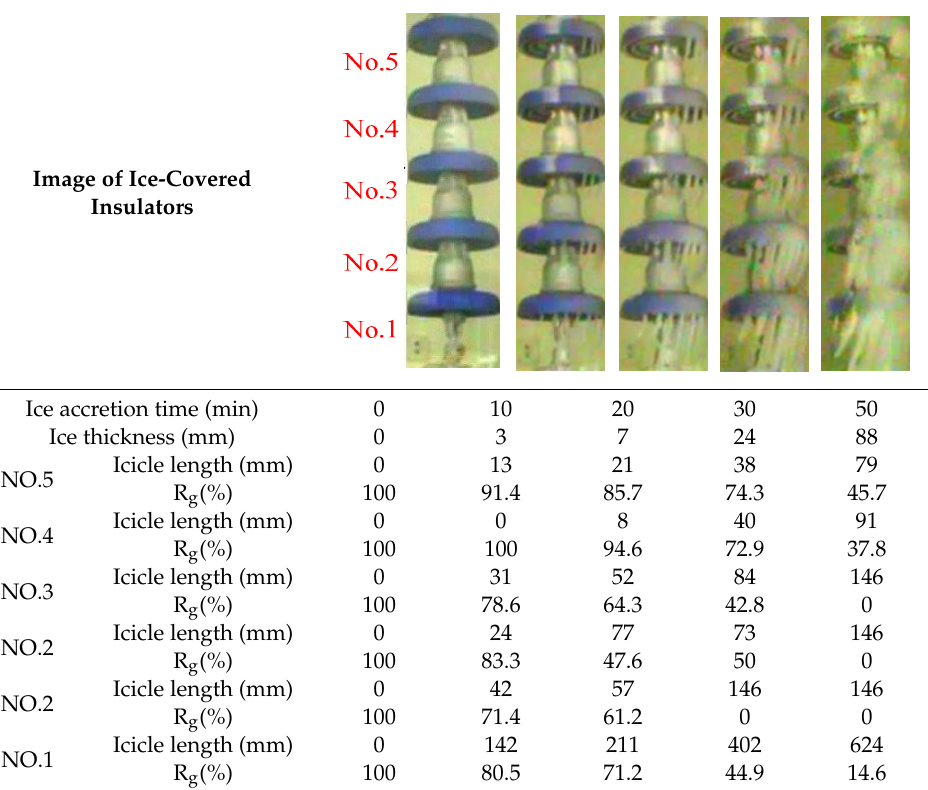
Table 2. The results of ice thickness, icicle length, and Rg.